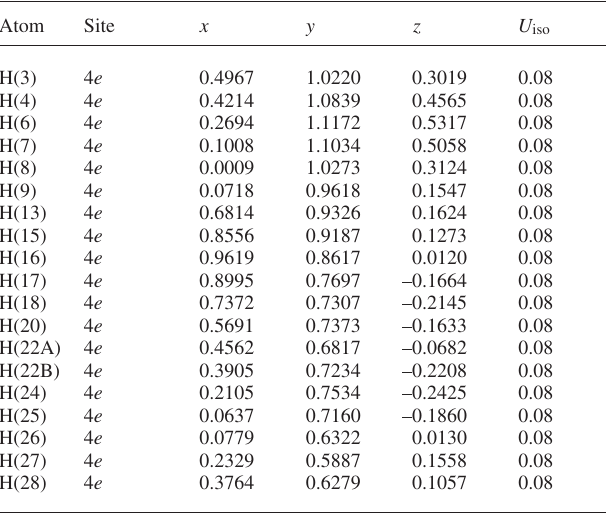
Table 2. Atomic coordinates and displacement parameters (in Å 2 )